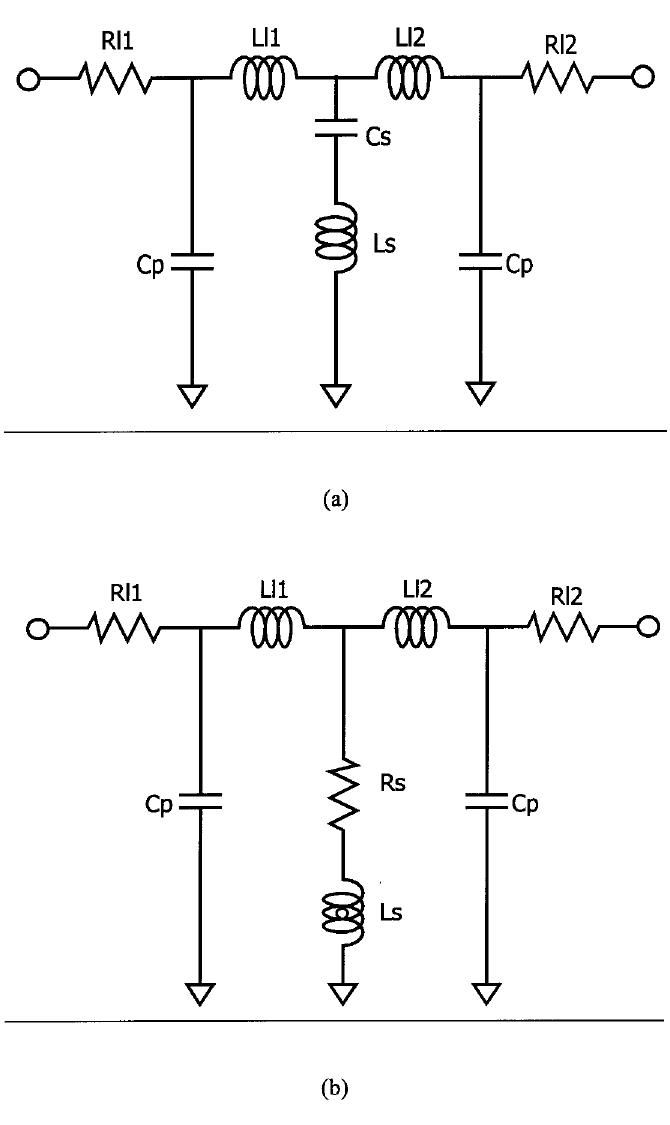
FIGURE 4 A generic equivalent circuit model of a shunt RF MEM switch for (a) on state and (b) off